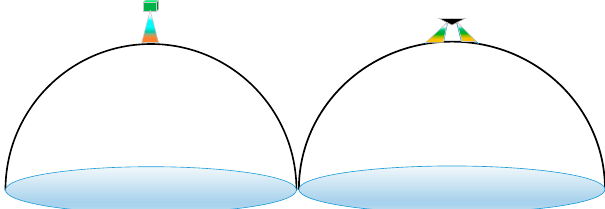
Figure 1. A sketch for single-antenna observation mode of TDS-1 ( left ) and dual-antenna observation mode of CYGNSS( right ).